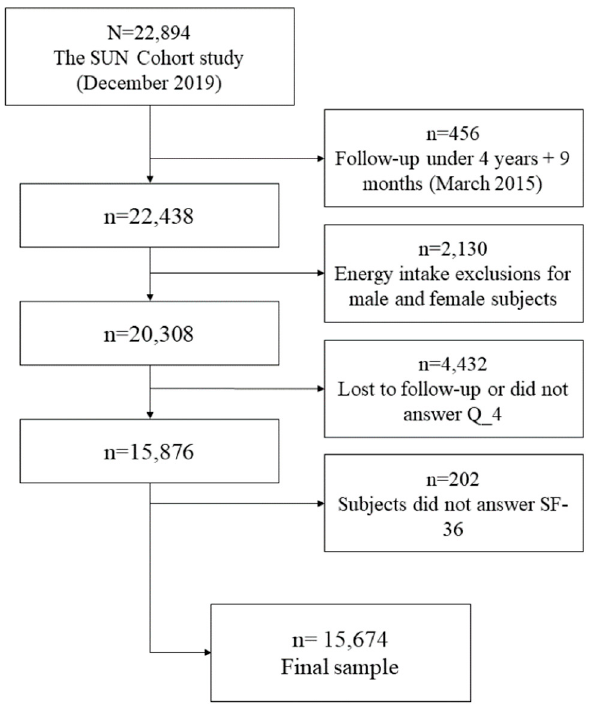
Figure 1. Flow chart and exclusion criteria for the present sample.